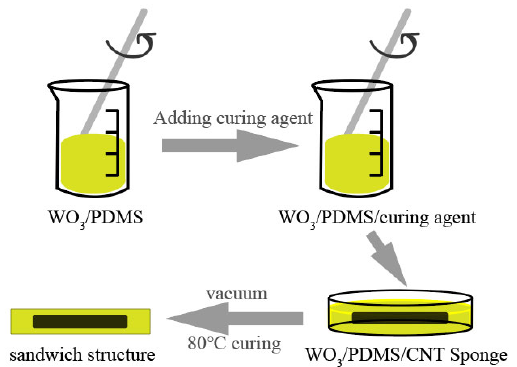
Figure 1. Flow chart of the force-sensitive structure’s processing and preparation.